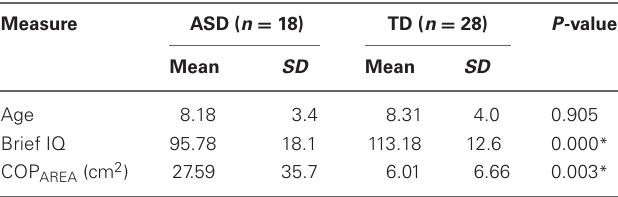
Table 1 | Means and standard deviations (SD) for age, non-verbal IQ, and measures of COP variability during quiet